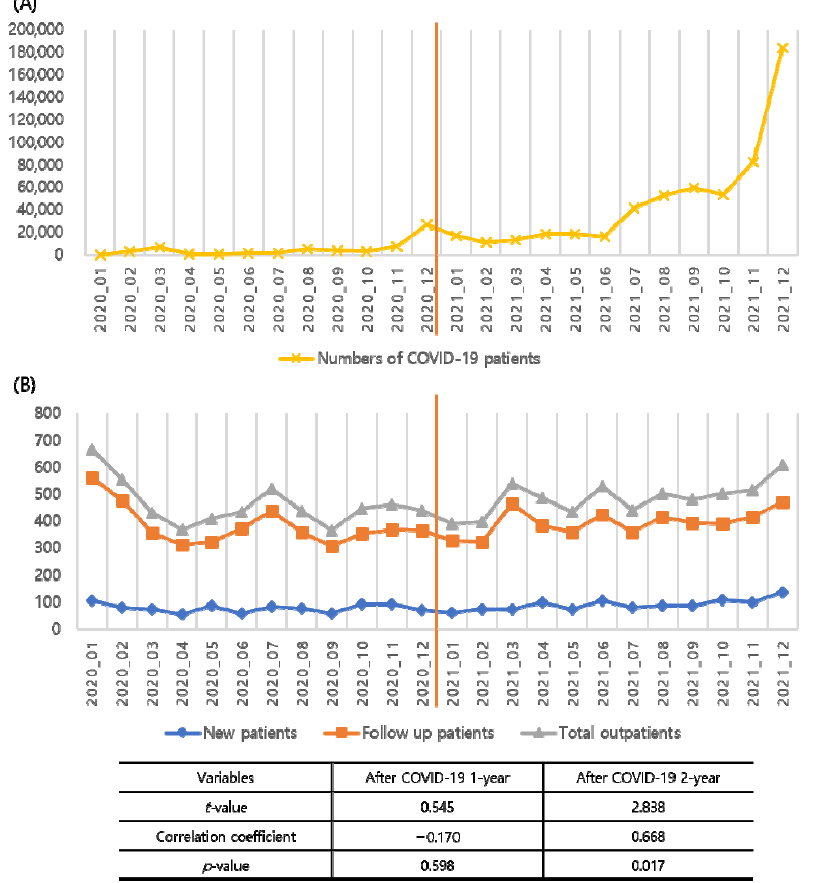
Figure 2. Monthly numbers of COVID-19 diagnosed patients in Korea ( A ) and monthly outpatient numbers in author’s hospital ( B ).